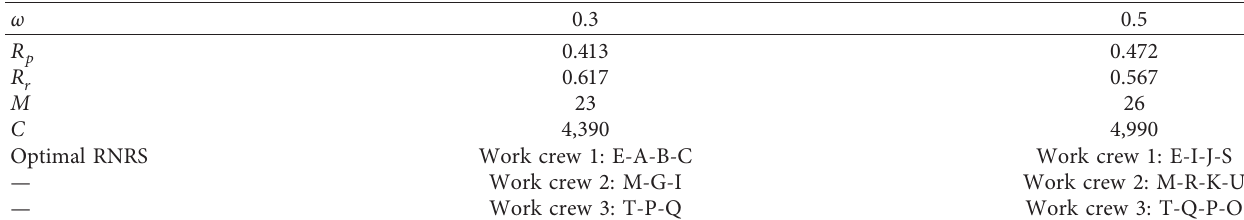
Table 8: Effect of ω on the optimal